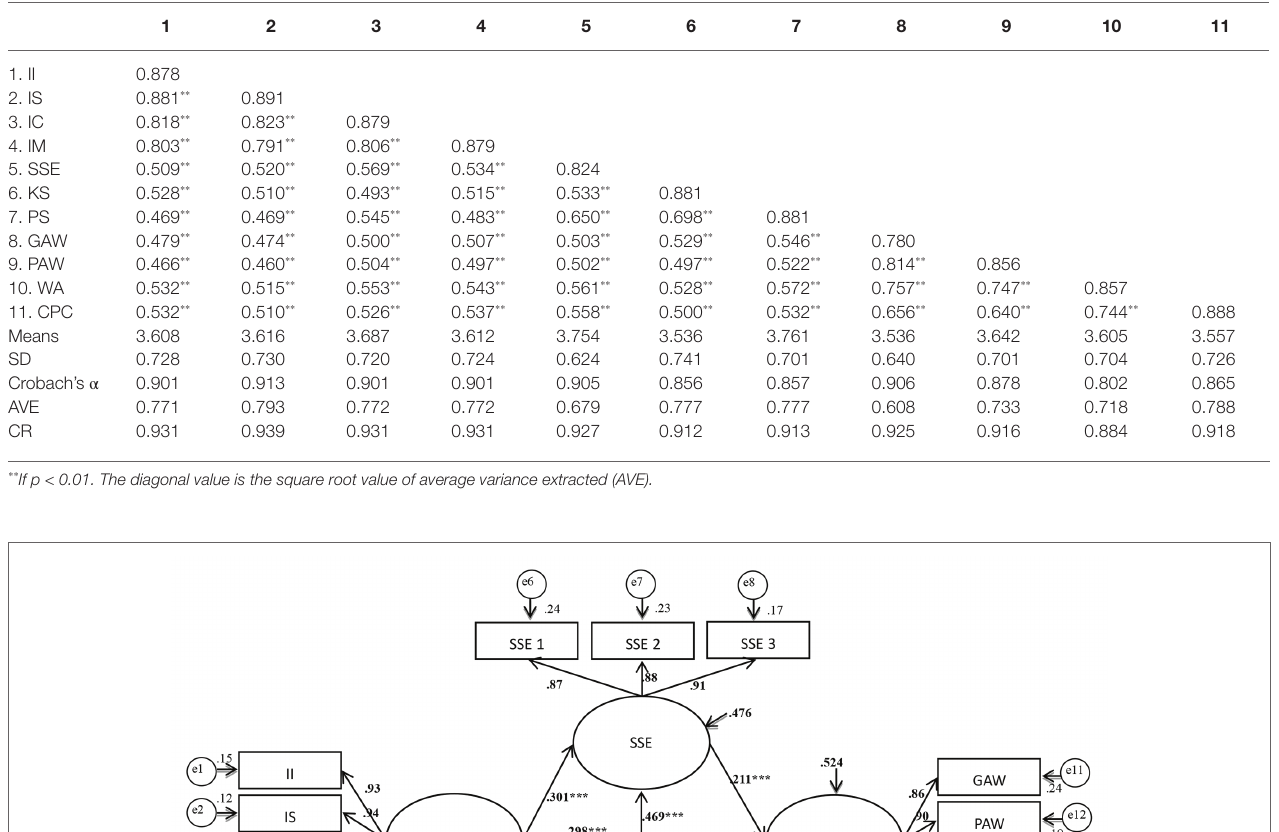
TABLE 2 | Measurement